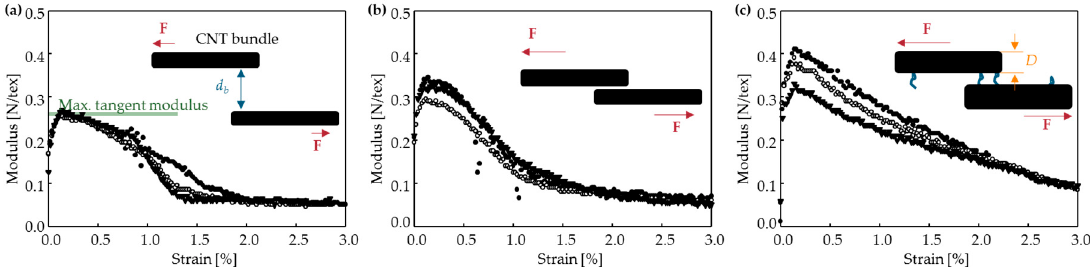
Figure 7. The modulus-strain curves: ( a ) Pristine, ( b ) pressed , and ( c ) AAD pressed and CL . Maximum modulus increased after the fibers were treated.